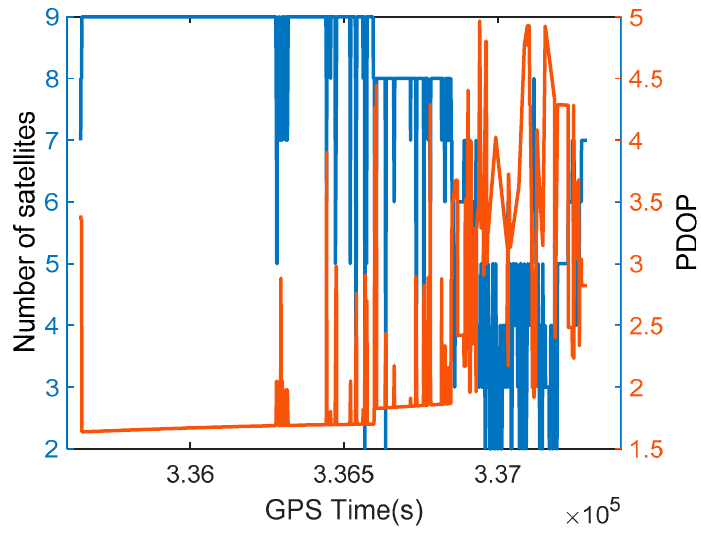
Figure 9. The number of visible satellites and the PDOP.